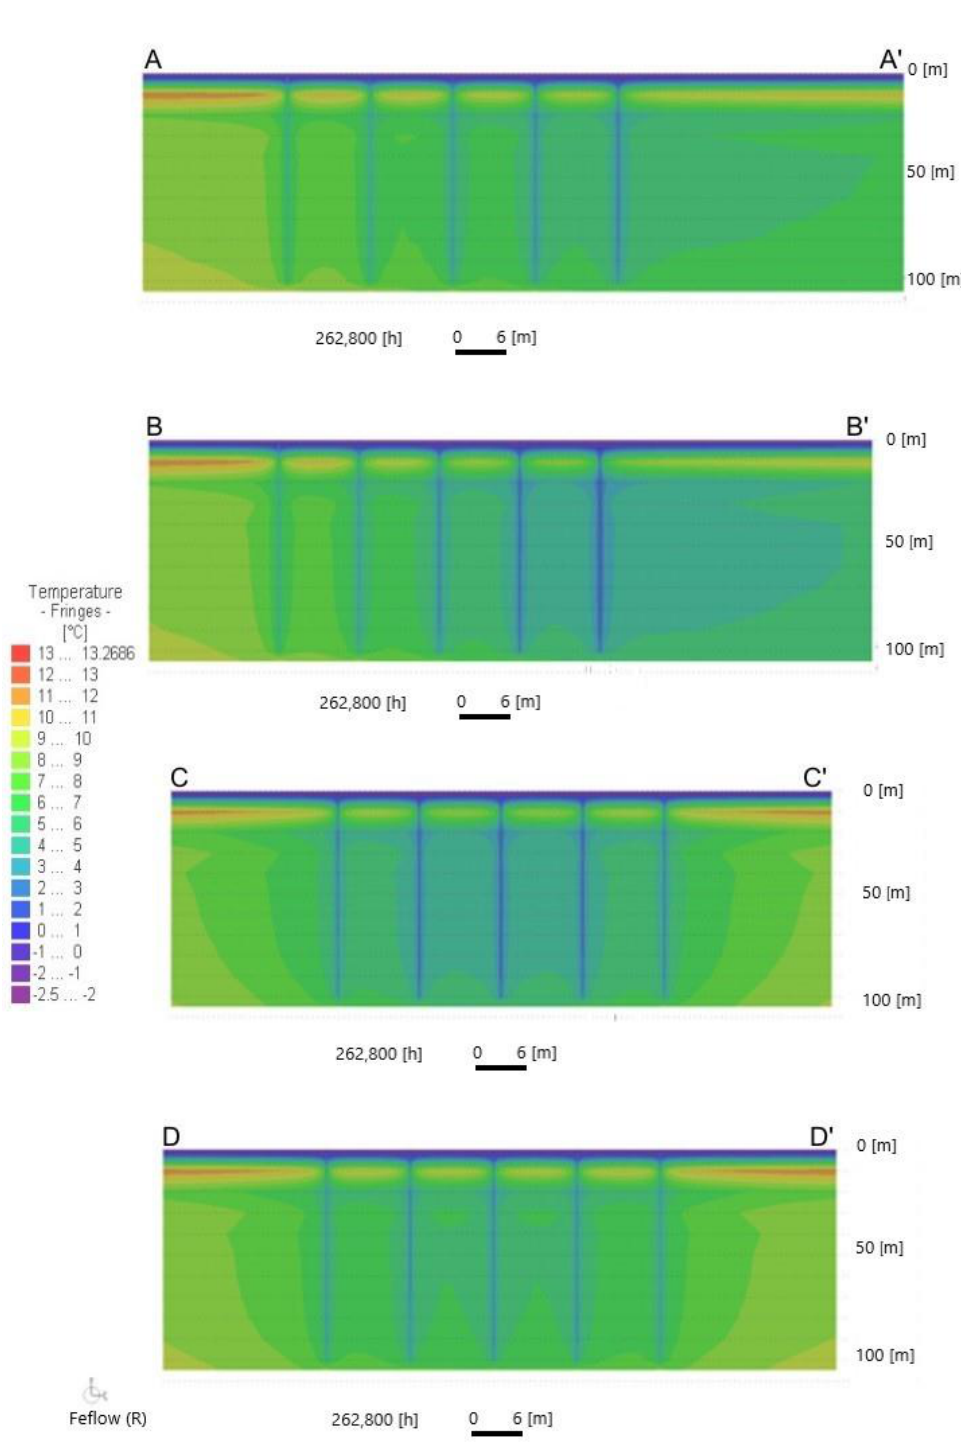
Figure 12. The temperature distribution as cross-section views for the 2nd scenario. The cross-section lines are the same as those used in Figure 1.